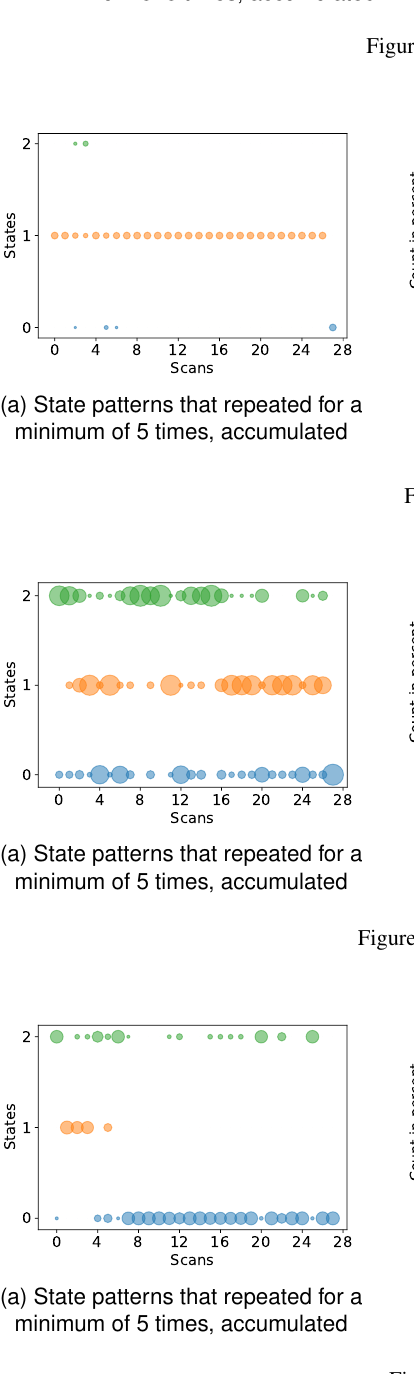
Figure 14. Pattern distribution for a parked